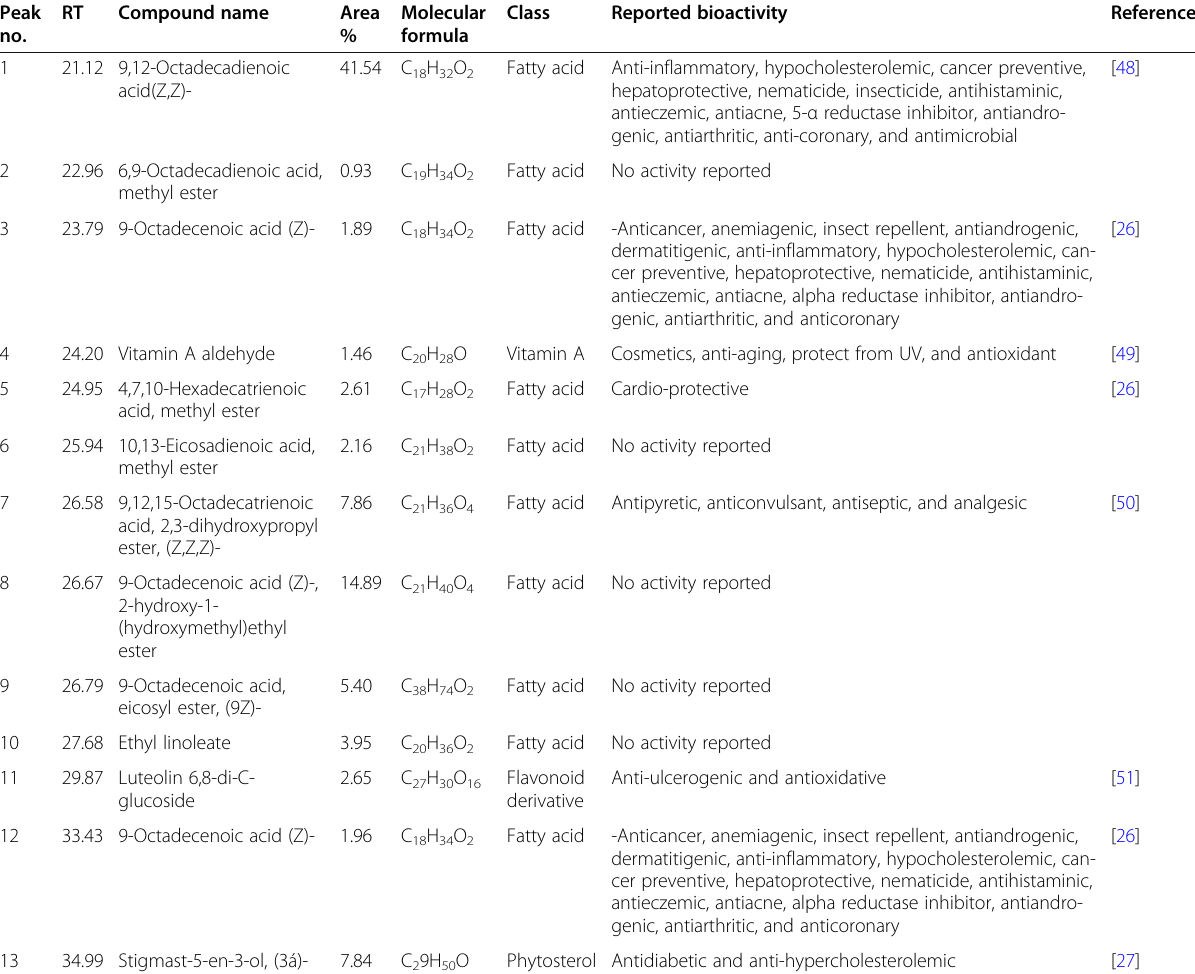
Table 6 Phytochemical components of Conzya dioscoridis ethanolic extract as identified by GC-MS analysis Peak